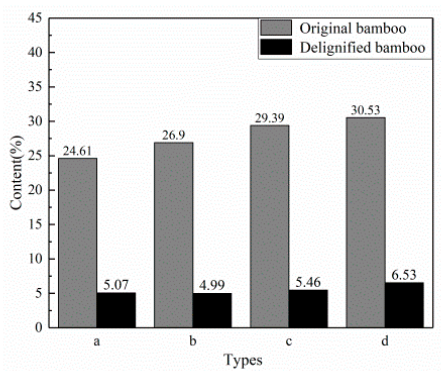
Figure 6. Lignin content of the delignified samples (a) IB; (b) HIB; (c) OB; (d) HOB.